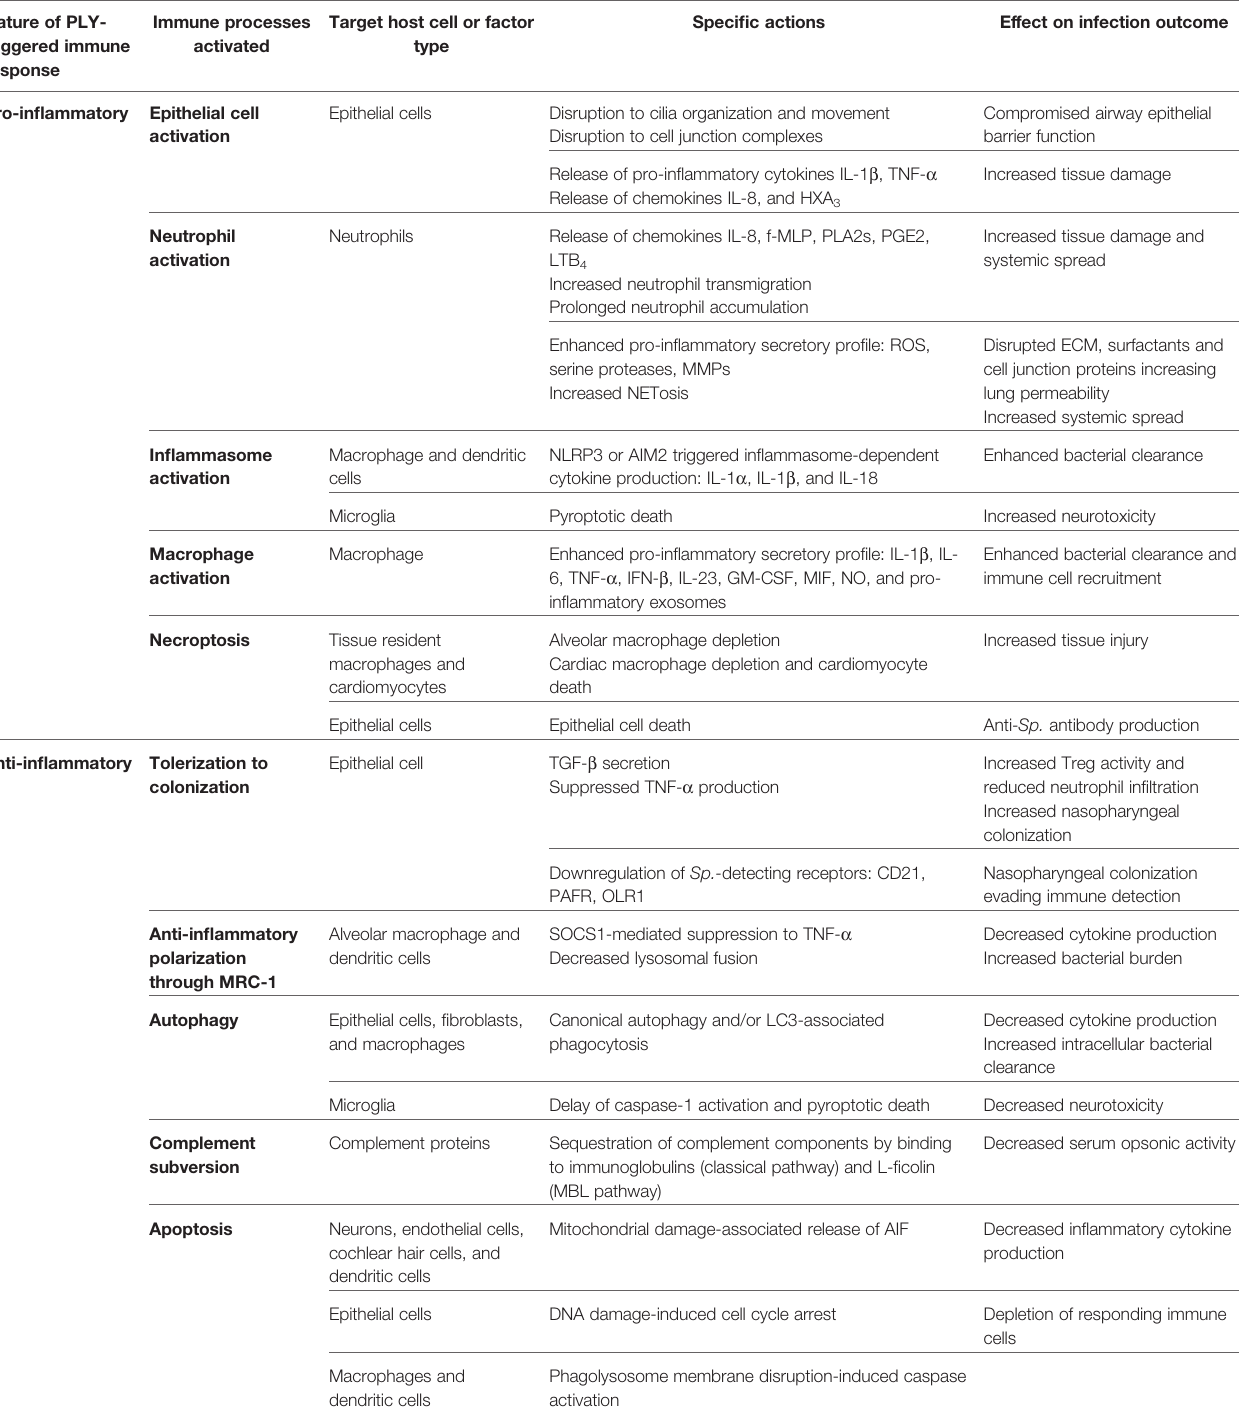
TABLE 1 | PLY-triggered pro- and anti-in fl ammatory immune modulations. Nature of PLY- triggered